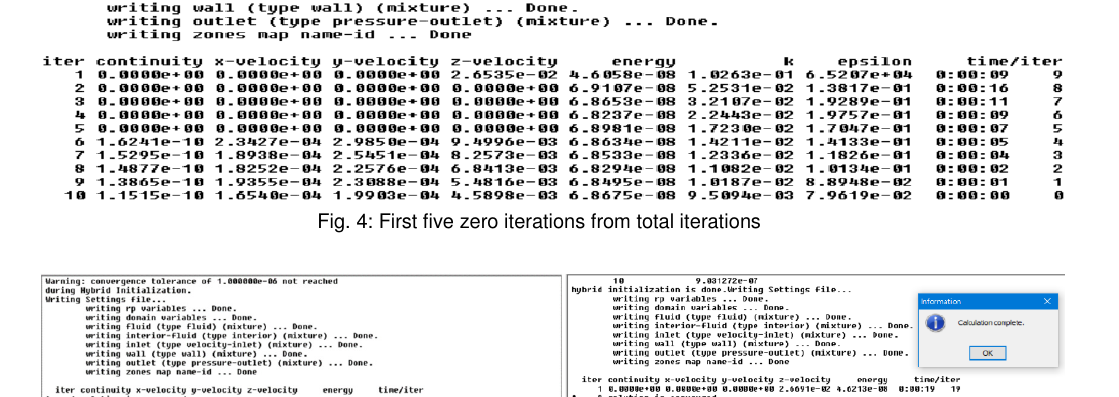
Fig. 5(a): 1-Solution is converged Fig. 5(b): 2-Solution is converged